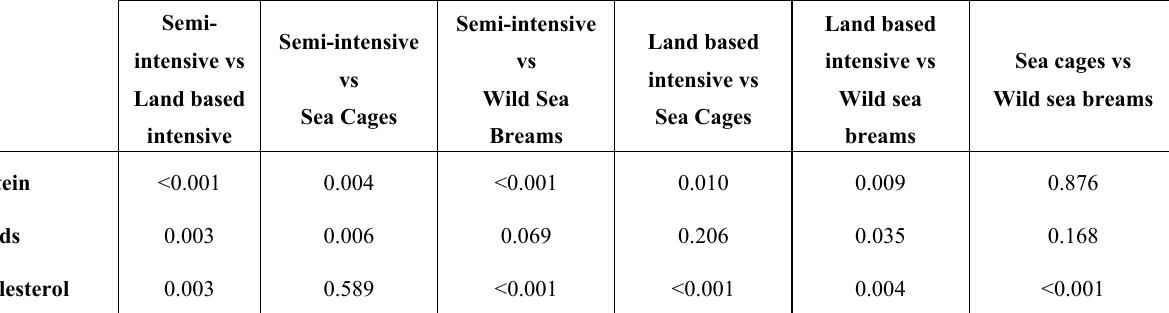
Table 2. Significance of differences (p-values) in hepatic protein, lipids and cholesterol contents for the three different rearing systems, and wild samples (control) at the end of trial, based on a t-test for 3 independent samples. Homogeneity of variances is always satisfied at a p-value of